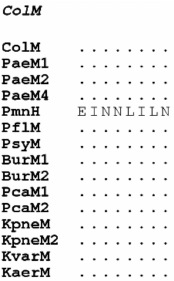
Figure 9. Sequence alignment of ColM and its homologs. The strictly conserved residues are highlighted in red, and the conserved residues in yellow. The strong sequence homology identified in the C-terminal part is boxed in red. The secondary structures of ColM are represented above the alignment. The amino acid residues essential for ColM activity are indicated in red below the sequences. This sequence alignment was generated with the ClustalW program and visualized thanks to the ESPript program [70].